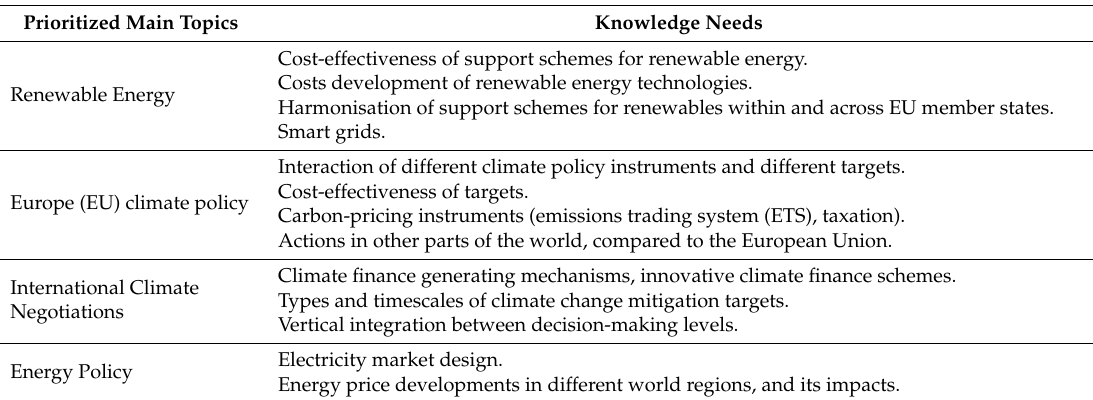
Table 3. Key knowledge needs and priorities.